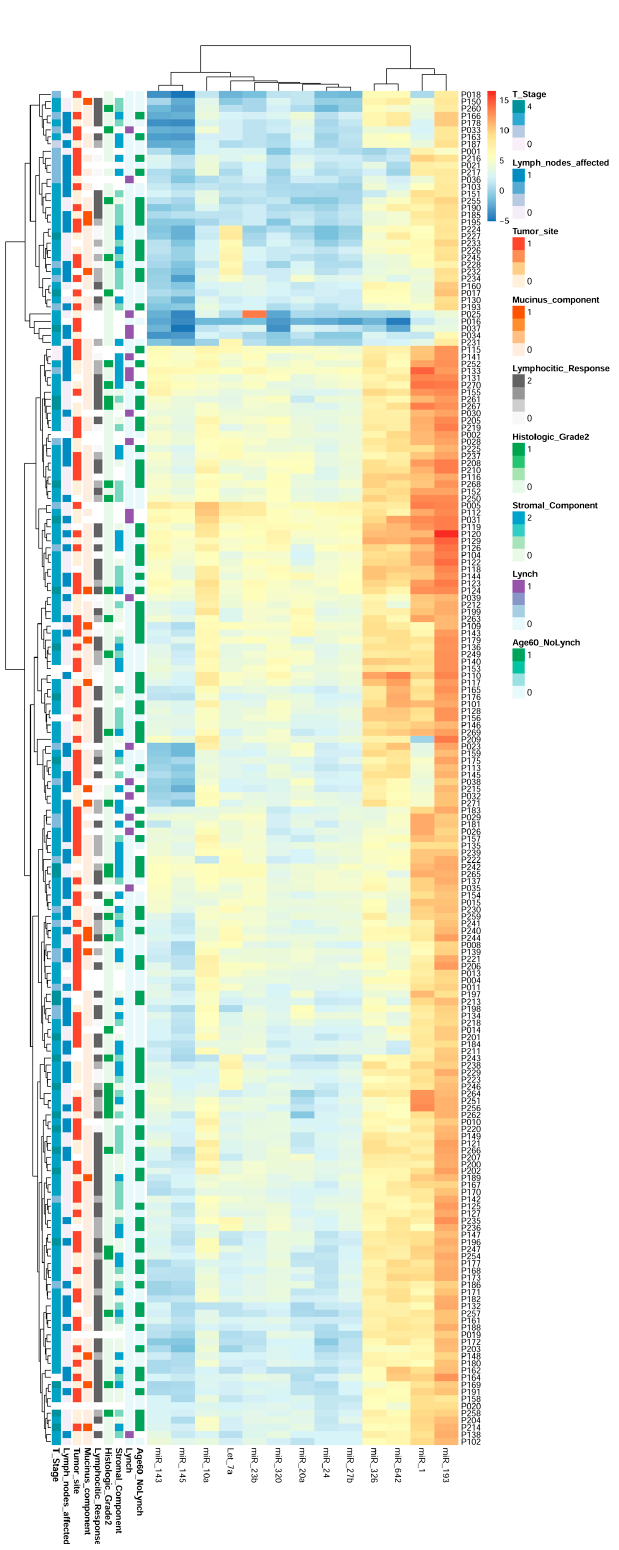
Figure 9. Heat map and hierarchical cluster of the validated miRNAs reclassifying CRC patients. The 13 validated miRNAs analysed by qRT-PCR in 192 CRC human biopsies allows for a new classification of the patients into 2 groups, which is independent of clinical features and based on miRNA pattern